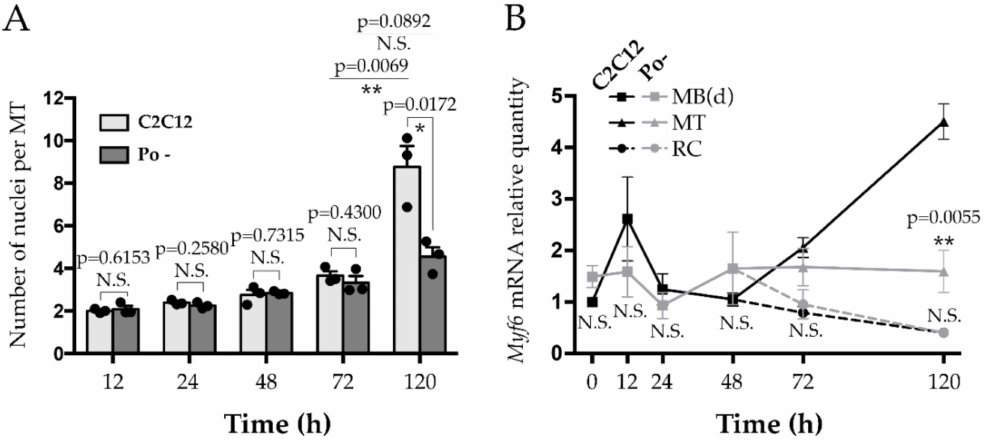
Figure 1. Timing of secondary fusion in C2C12 cell lines. ( A ) Mean number of nuclei in myotubes from wild-type (WT) C2C12 and Pofut1 knockdown (Po –) cells during myogenic di ff erentiation time course. ( B ) Relative quantities of Myf6 expression in WT C2C12 (black) and Po – cells (grey). During myogenic fusion, some of the di ff erentiating myoblasts (MB(d)) will fuse together leading to the formation of myotubes (MT), while others will generate mononucleated reserve cells (RC) that will participate in MT growth during secondary fusion. All experiments were performed in biological triplicates. In both cell lines, fold changes were relative to time 0 h of WT C2C12. Bar graphs and plots represented means ± SEM (Standard Error of the Mean). In ( A ), each mean of replicates was symbolized by a dark dot. Statistical analyses were done using a two-tailed Student test, which compared within and between di ff erentiation times, and according to both cell types, MT and RC. * p < 0.05; ** p < 0.01. N.S., not